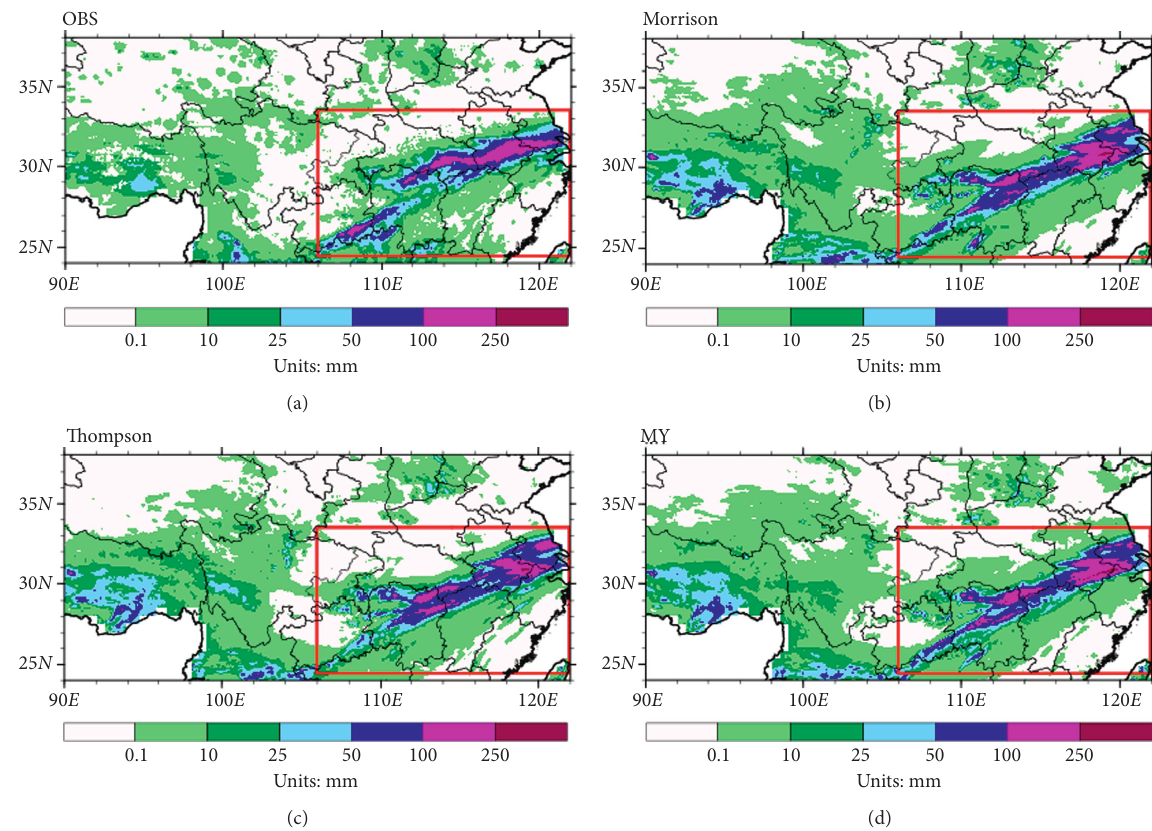
Figure 4: Spatial distribution of cumulative rainfall in 24 hours for (a) the observations and ((b)-(d)) the WRF simulations using three microphysics schemes: (b) Morrison, (c) Thompson, and (d) MY.